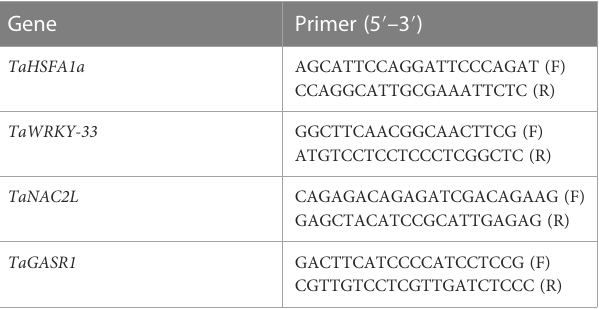
TABLE 1 Primers used in the estimation of relative gene expression.